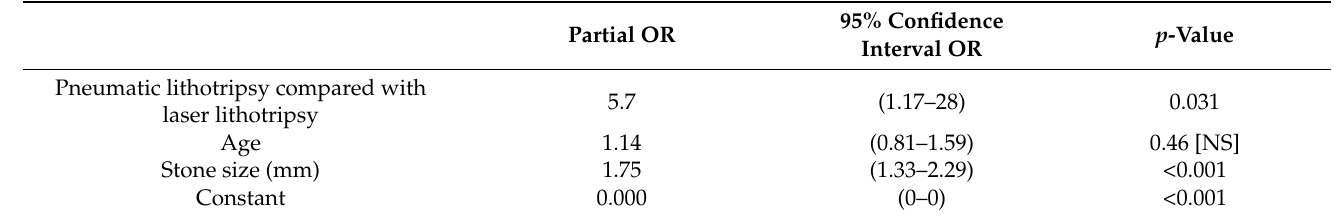
Table 3. Multiple regression model of the risk of developing at least one adverse outcome as the dependent